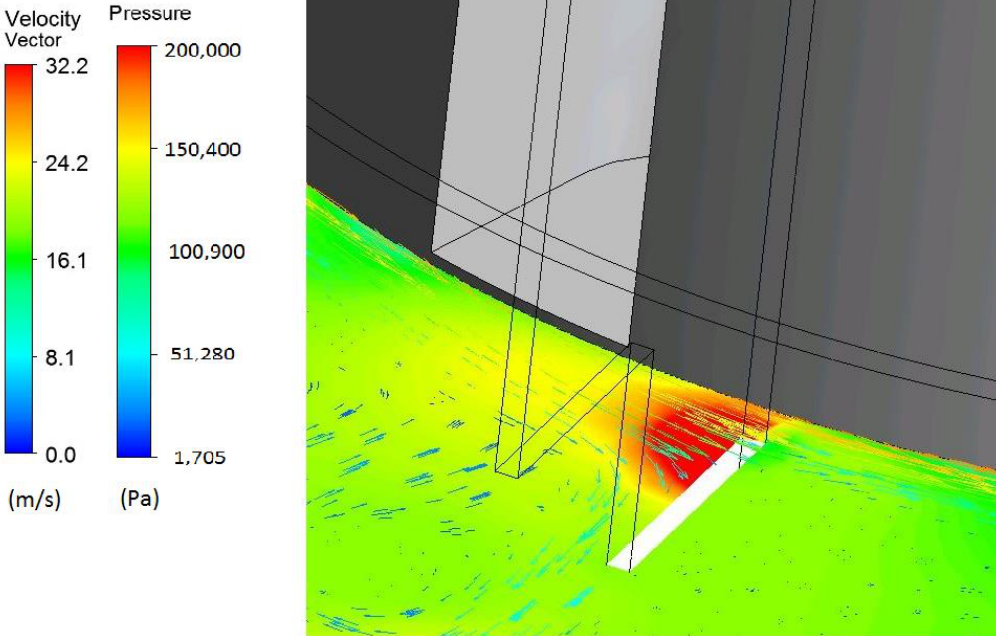
Figure 7. Pressure contour at the outlet from the rotor of the device in the modified variant, zoom-in to the outlet zone.